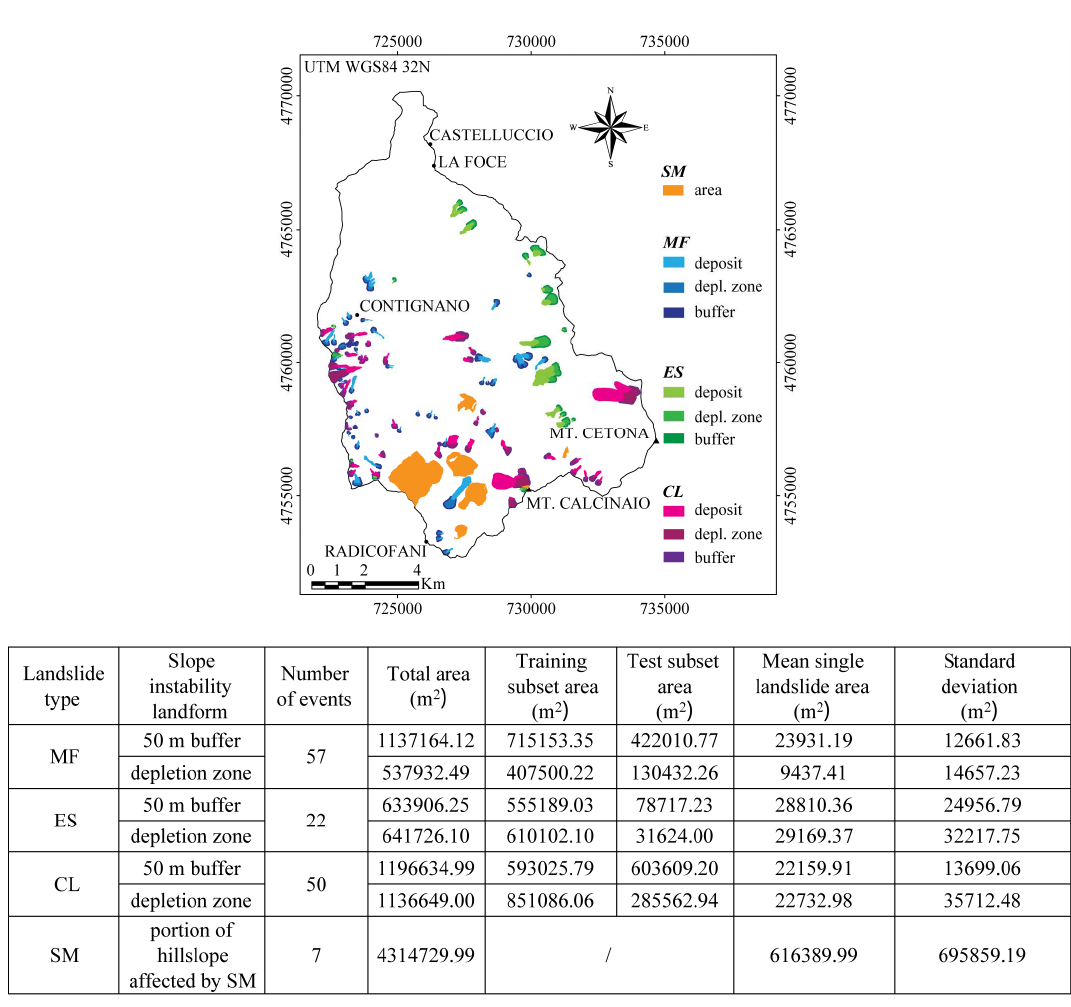
Fig. 4. Landslide inventory maps. For each landslide type, the deposit, the depletion zone, and the 50m outer buffer area from the depletion zone are shown. Total area and mean extent of each landslide type are listed in the table.